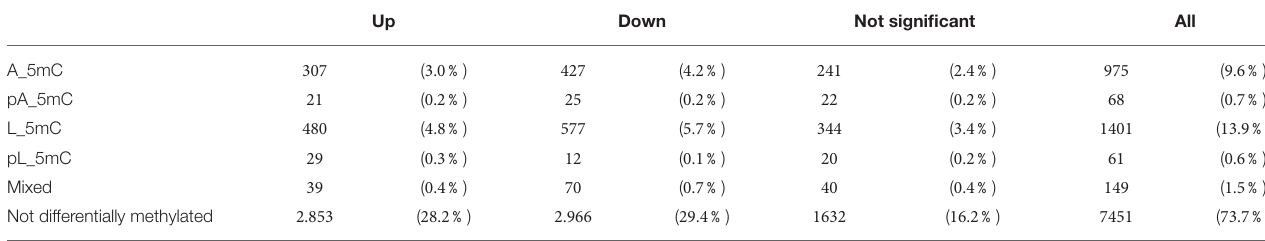
TABLE 1 | Classification of gene expression based on differential methylation analysis.